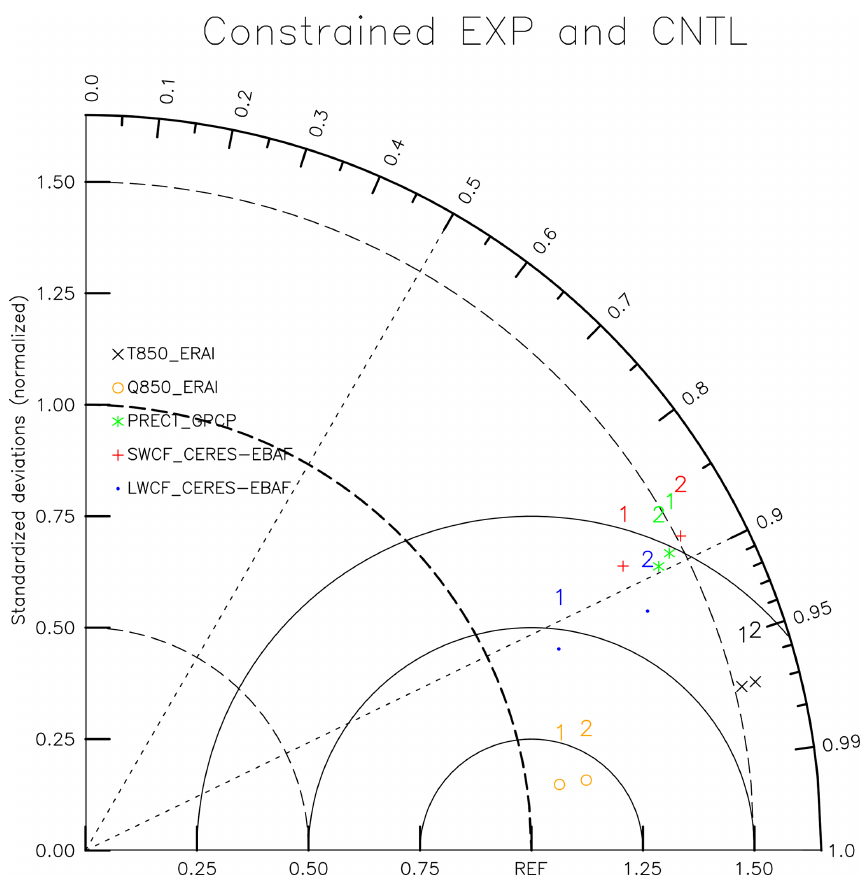
Figure 3. Taylor diagram of the climate mean state of each output variable from 2002 to 2004 between the model run with optimal parameters and the CNTL run. The number (1) in the diagram stands for EXP, and (2) stands for CNTL.